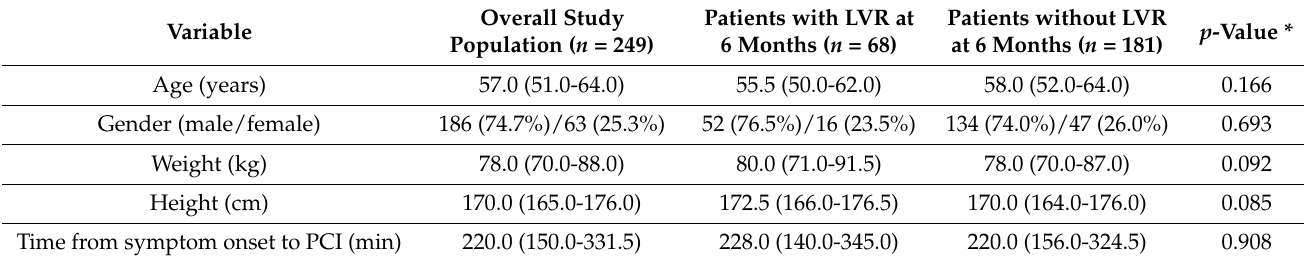
Table 1. Demographic, clinical, angiographic and biochemical characteristics of the study population (median (lower quartile-upper quartile) or number